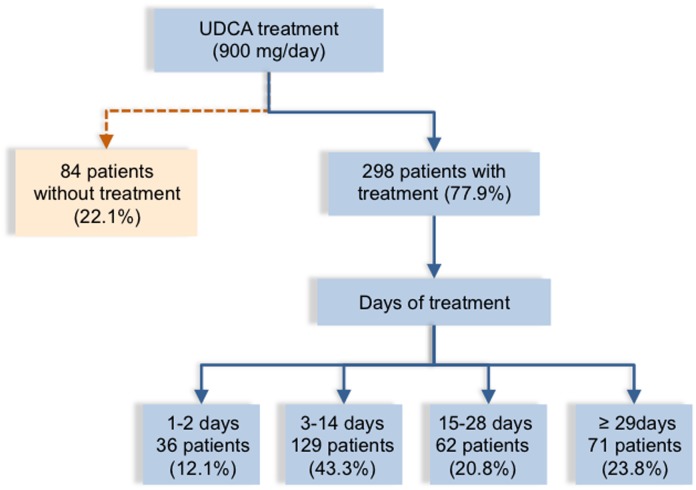
Flow chart of management of patients.Flow chart showing distribution of women with intrahepatic cholestasis of pregnancy (ICP) depending on whether they were not treated or treated with ursodeoxycholic acid (UDCA), together with days of treatment.